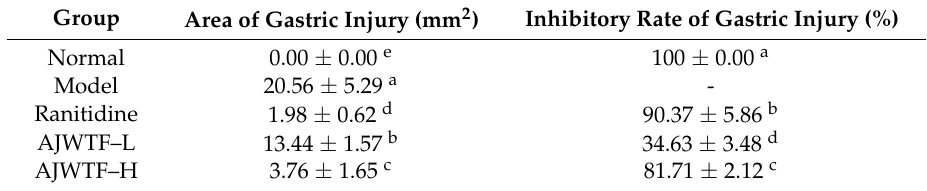
Table 3. Degrees of gastric injury in mice of each group ( n = 10).